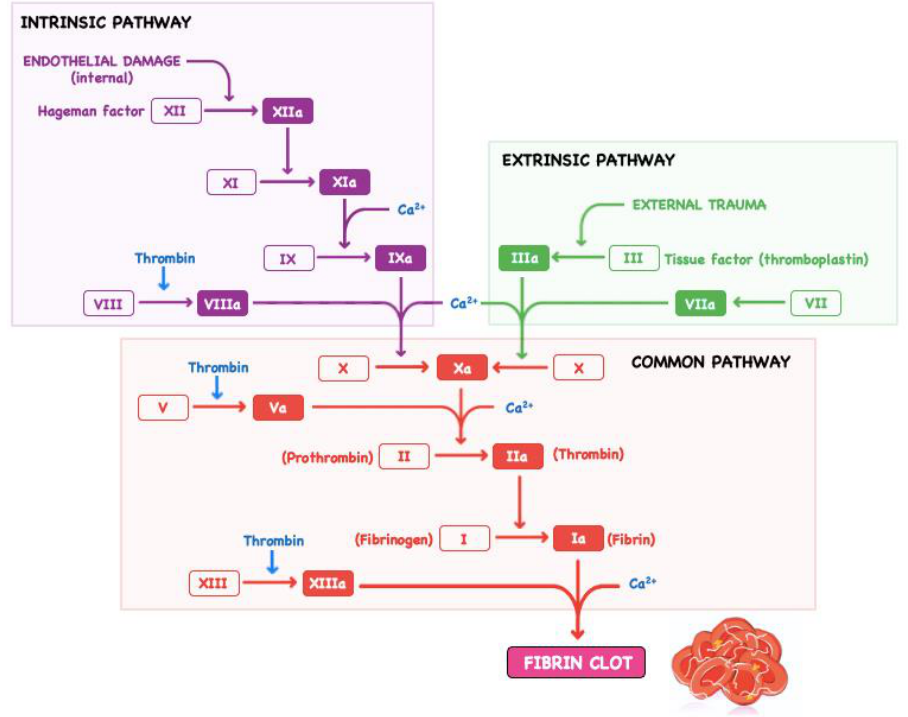
Figure 1. Schematic representation of coagulation cascade.